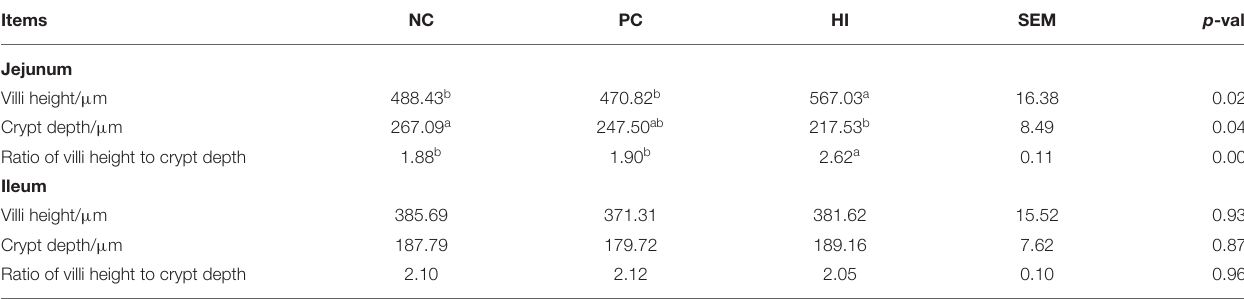
TABLE 5 | Effect of dietary Hermetia illucens larvae on intestinal morphology in weaned pigs. Items NC PC HI SEM p -value